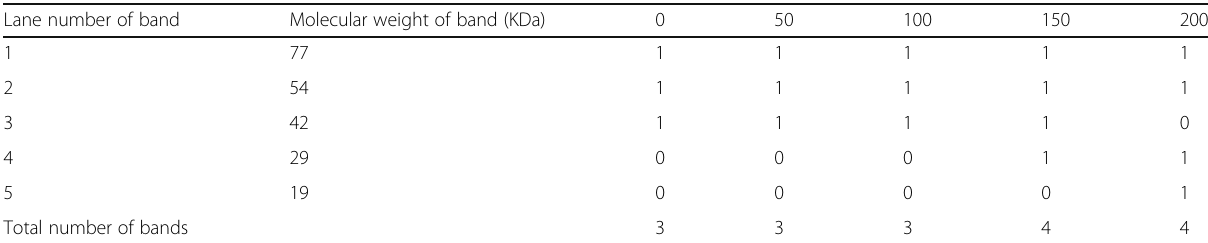
Table 3 Protein profile (presence and absence) in callus of date palm treated with Al (mg.l -1 ) obtained by SDS-PAGE technique Lane number of